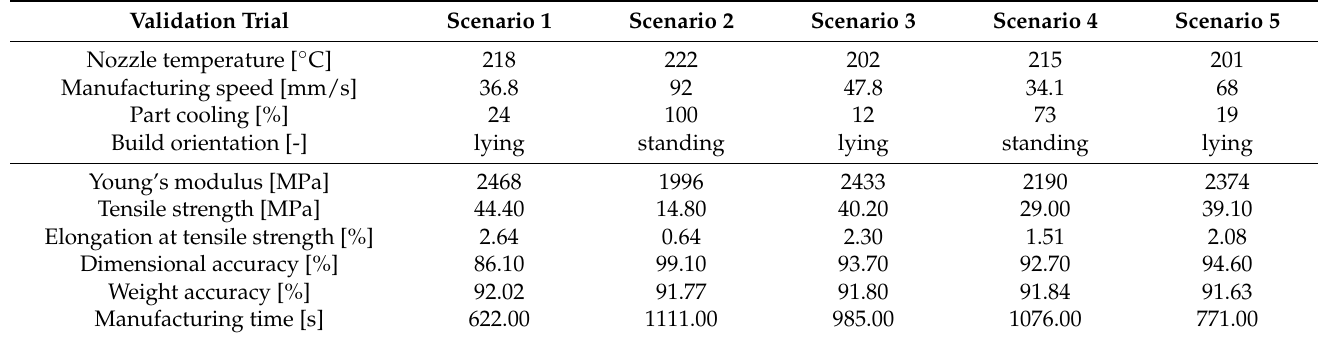
Table 5. Process parameters generated by the INN based on input from Table 4 and predicted part properties when using the generated